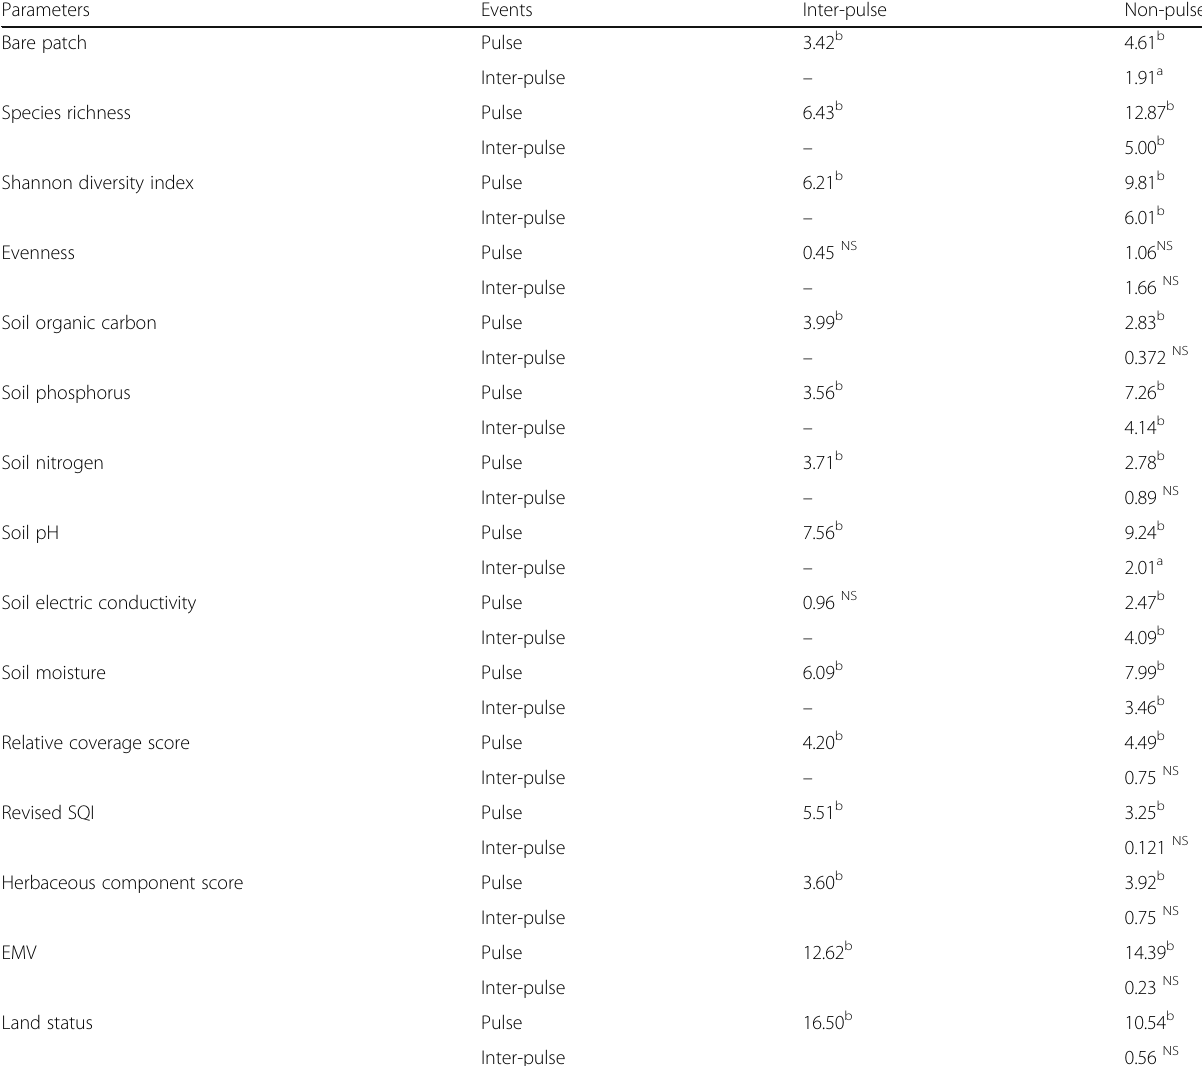
Table 7 Results of Student t test for various